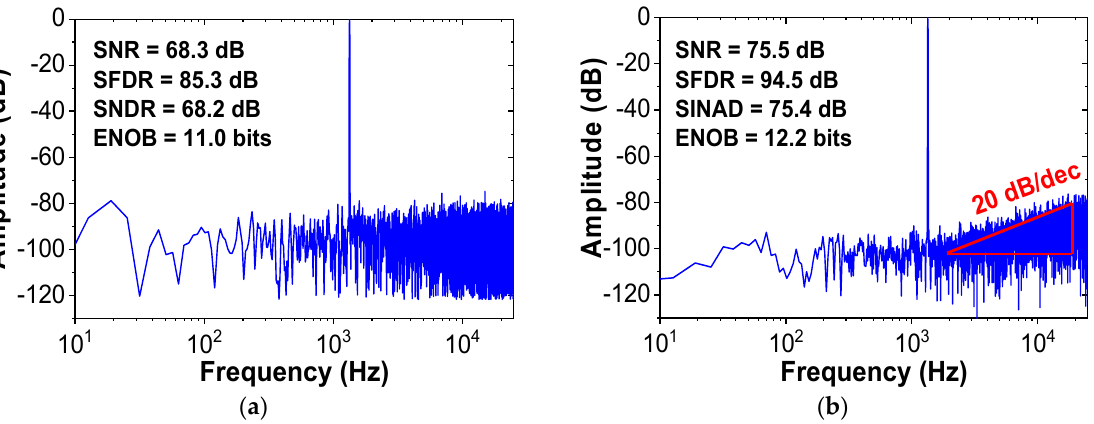
Figure 8. Output spectra of the ADC ( a ) without noise shaping and ( b ) with noise shaping for the CDAC mismatch rate of 0.5%. f in = 1.33 kHz and f S = 52 kHz.